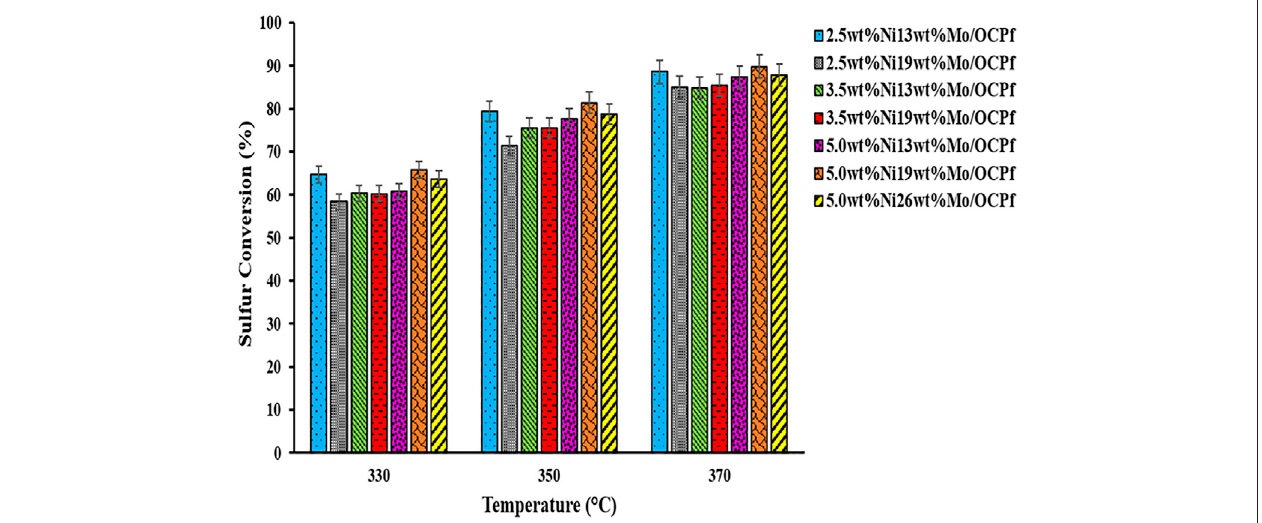
FIGURE7 | HDSactivities ofNiMo/OCP f catalysts with LGO at 330, 350, and 370 ° C (Catalyst (cid:2) 5 cm 3 , LHSV (cid:2) 2 h − 1 , P (cid:2) 9.0 MPa, and H 2 /oil ratio (cid:2) 600 (ml/ml)).